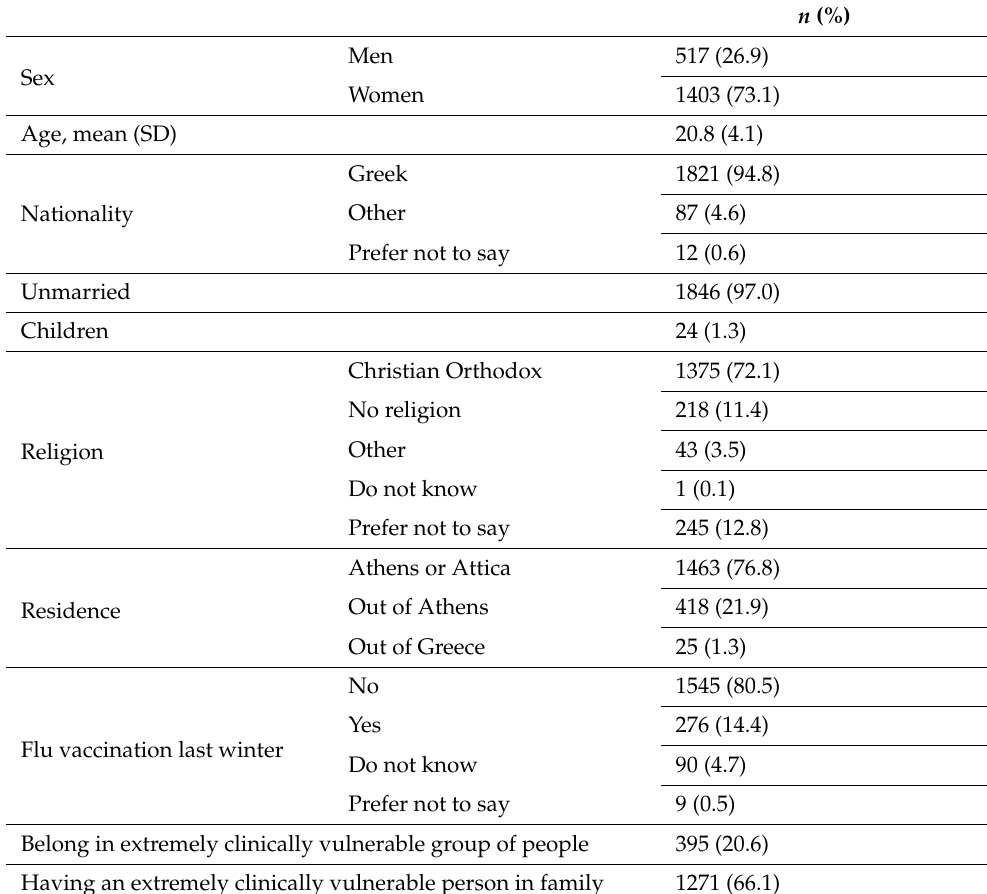
Table 1. Characteristics of participants.